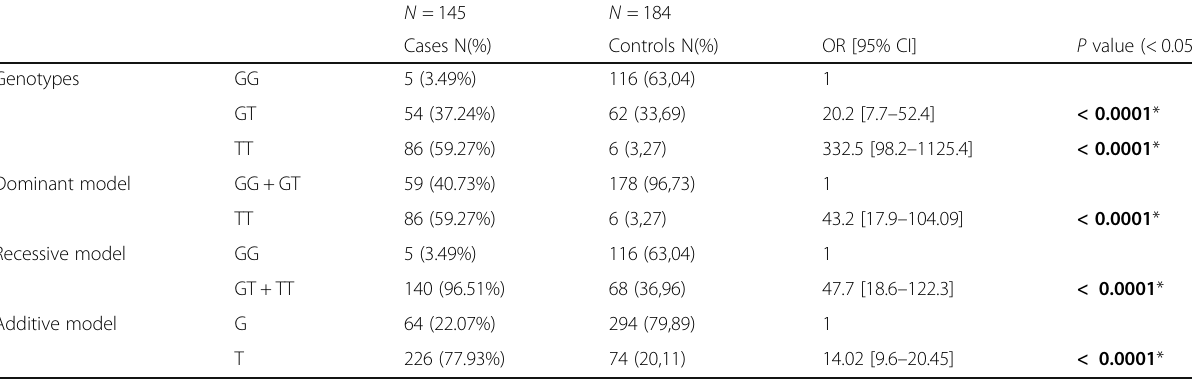
Table 3 Allelic and genotypic distribution of G894 T eNOS polymorphism among cases and controls N = 145 N = 184 Cases